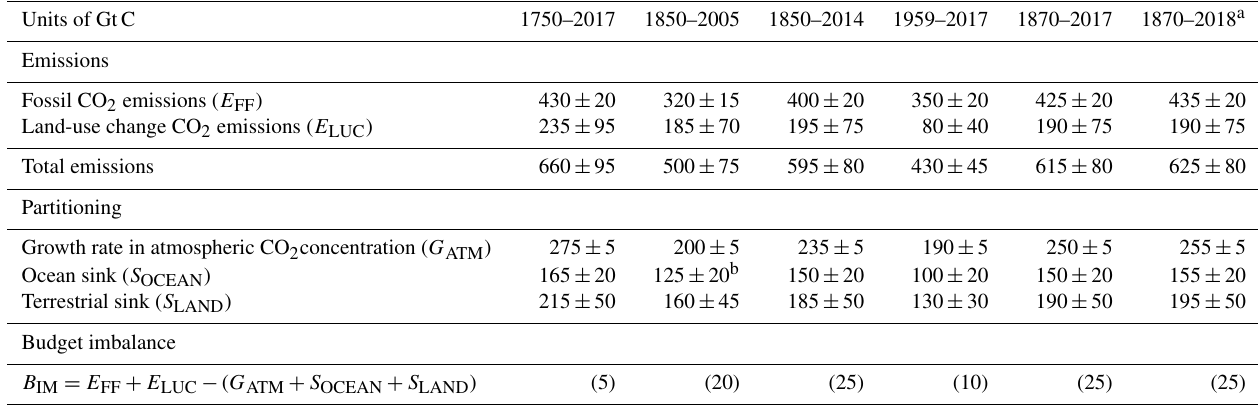
Table 8. Cumulative CO 2 for different time periods in gigatonnes of carbon (GtC). All uncertainties are reported as ± 1 σ . The budget imbalance provides a measure of the discrepancies among the nearly independent estimates. Its uncertainty exceeds ± 60GtC. The method used here does not capture the loss of additional sink capacity from reduced forest cover, which is about 20GtC and would exacerbate the budget imbalance (see Sect. 2.8.4). All values are rounded to the nearest 5GtC and therefore columns do not necessarily add to